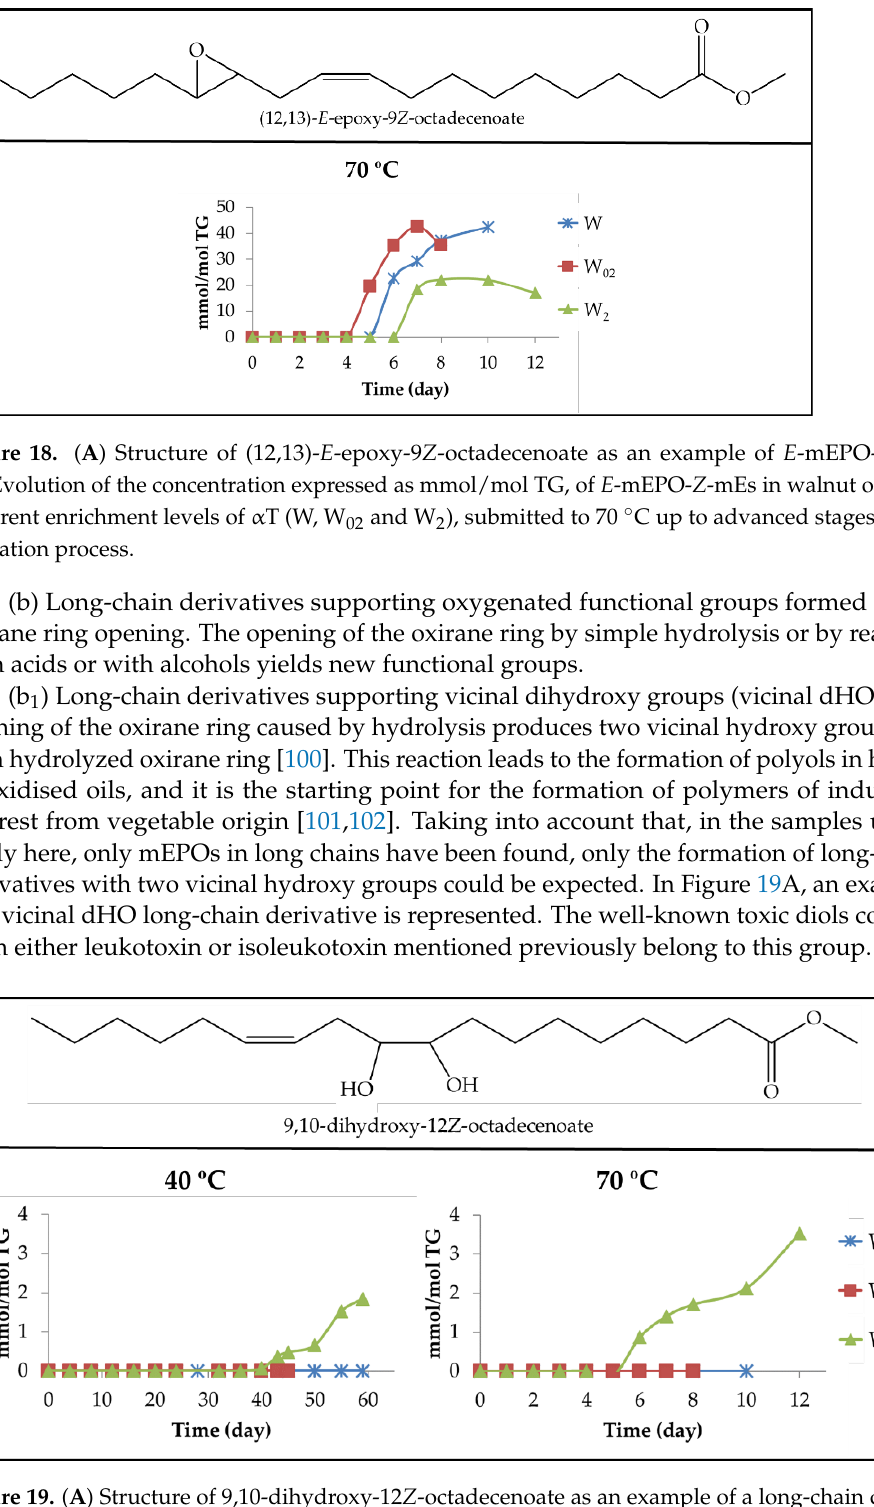
Figure 18. ( A ) Structure of (12,13)- E -epoxy-9 Z -octadecenoate as an example of E -mEPO- Z -mE. ( B ) Evolution of the concentration expressed as mmol/mol TG, of E -mEPO- Z -mEs in walnut oil with different enrichment levels of αT (W, W 02 and W 2 ), submitted to 70 °C up to advanced stages of the oxidation process.